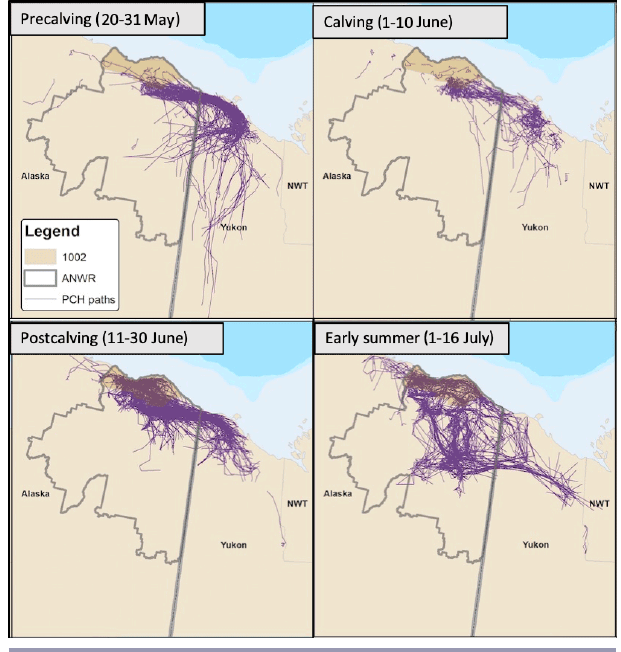
Fig. 4 . Seasonal movement paths of radio-collared Porcupine Caribou cows from 1986 to 2018 in relation to the 1002 area in Alaska.